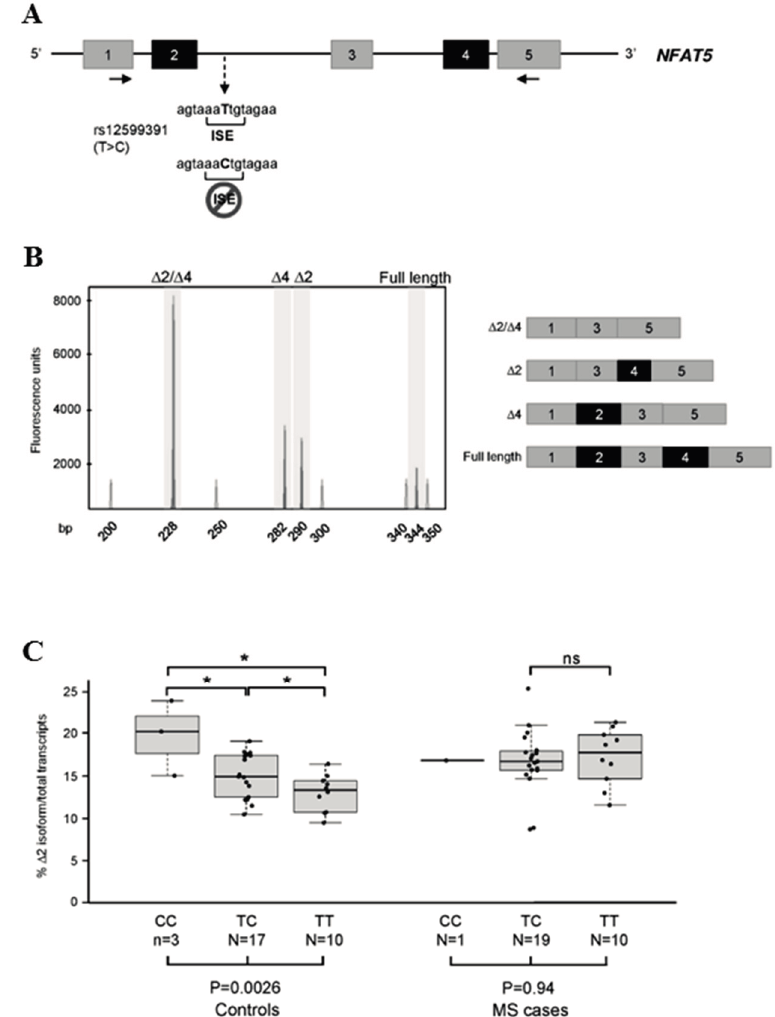
Figure 2. Splicing pattern analysis of the NFAT5 gene. ( A ) Schematic representation of the NFAT5 gene between exons 1 and 5. Exons and introns are represented by boxes and lines, and are approximately drawn to scale. Exons indicated in black are those undergoing alternatively skipping (alone or in combination). The positions of the primer couple used for competitive fluorescent RT-PCR experiments are shown by arrows (the forward primer was labeled with the FAM fluorophore). The C > T transition (rs12599391) abolishing the intron-2 ISE element is also indicated; ( B ) Fluorescent RT-PCR products, obtained from the RNA extracted from PBMCs of a control individual (heterozygous CT for the rs12599391 polymorphism), were separated by using capillary electrophoresis. The panel on the left is a close-up view of the GeneMapper window encompassing all peaks corresponding to different isoforms. A schematic representation of the obtained RT-PCR products is also depicted on the right; ( C ) Boxplot diagram showing the percentage of the exon-2-including transcripts among all NFAT5 mRNAs, according to disease status and by stratifying individuals on the basis of their rs12599391 genotype. Expression levels were measured by fluorescent competitive RT-PCRs. Significance levels of t -tests and of the one-way ANOVA analyses, are shown above and below the boxplots, respectively. * p < 0.05; ns: not